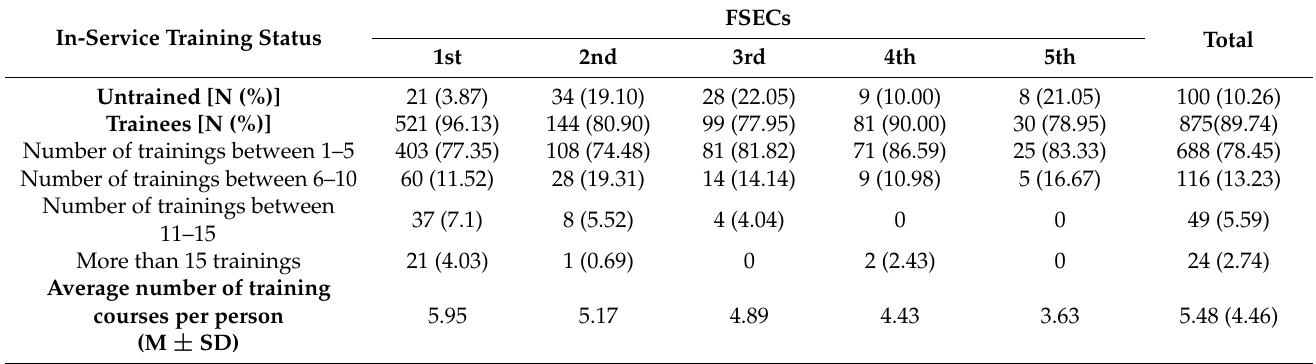
Table 4. In-service training status of